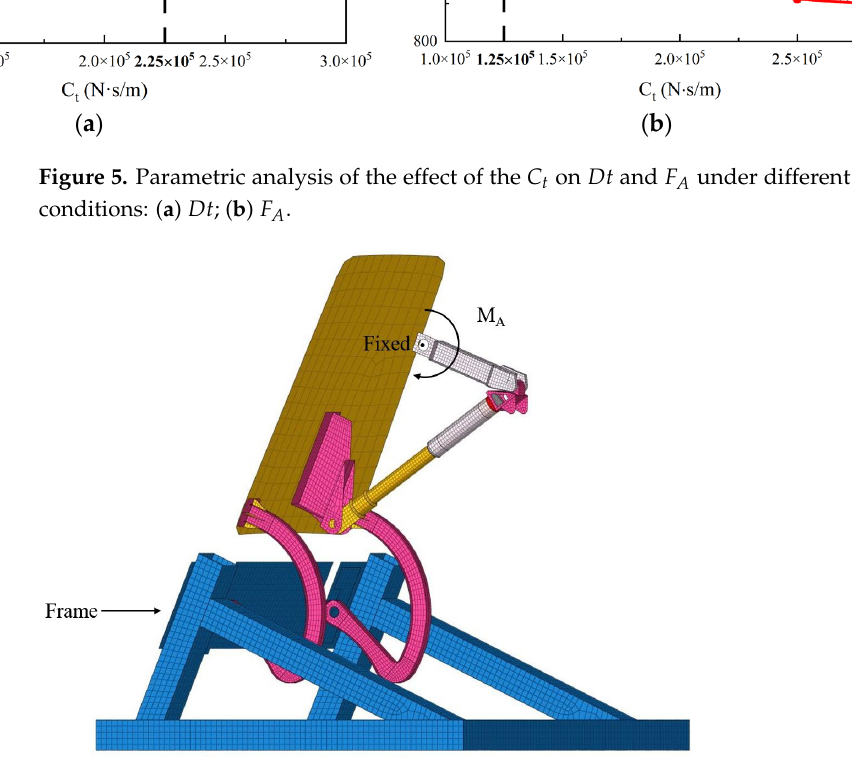
Figure 6. FE model of the trim flap system fixed on the aluminum alloy frame.